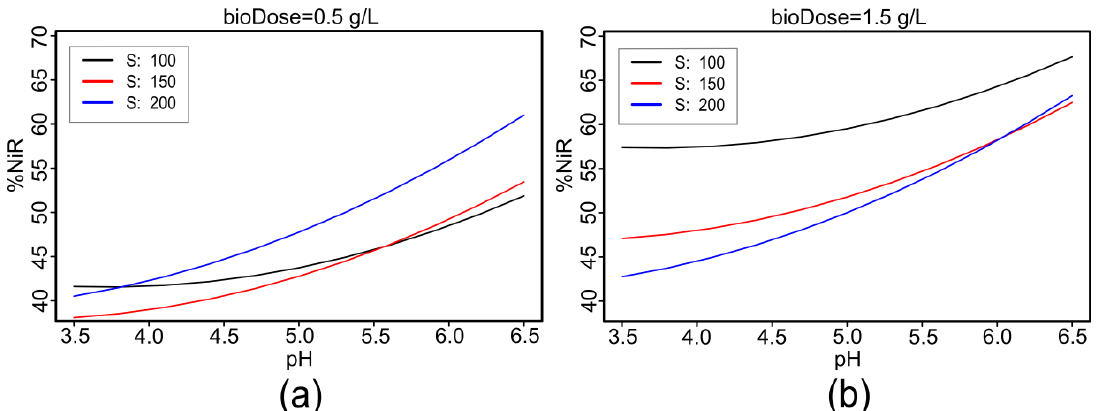
Figure 3. Variation of %NiR vs pH for di ff erent values of S when: ( a ) bioDose = 0.5 g / L; ( b ) bioDose = 1.5 g / L.